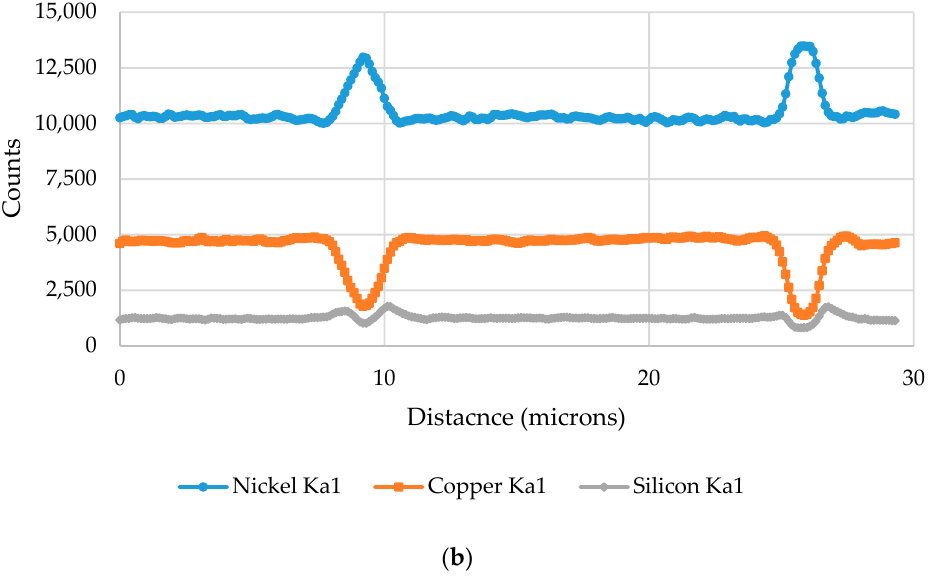
Figure 8. EDS line scan analysis across the dendritic and inter-dendritic phases on an as-polished 30/70 deposit. The complementary rises and drops in the copper and nickel counts are indicative of the presence of nickel boride as the inter-dendritic phase.